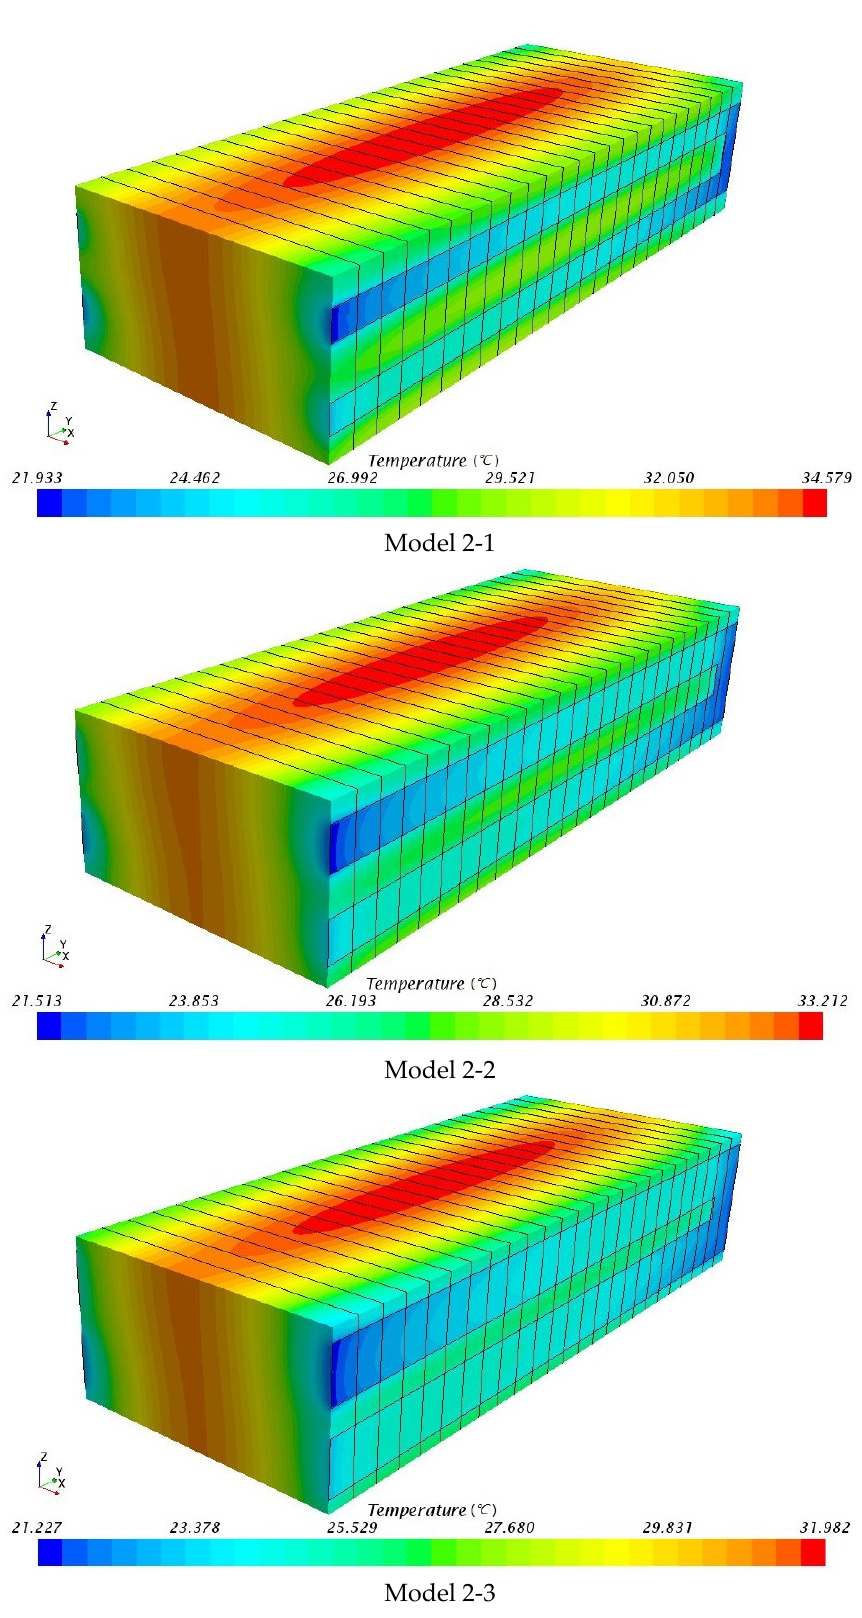
Figure 9. Temperature distributions of the three models with the side cooling system.